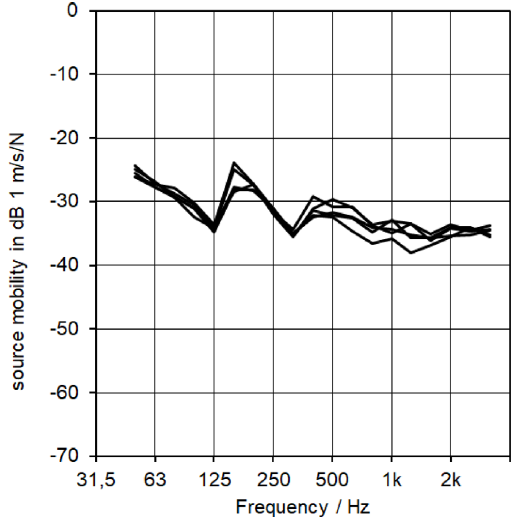
Figure 17. Reproducibility standard deviation of the single equivalent free velocity level.